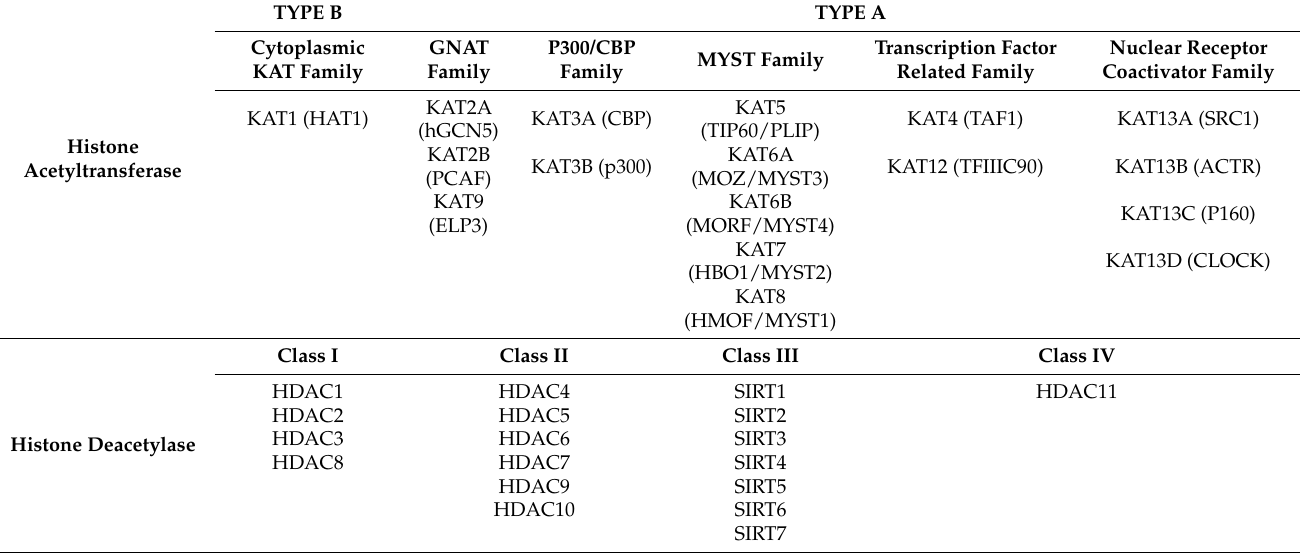
Table 1. Histone acetylation and deacetylation are performed by KATs and HDACs, respectively. Two types of KATs are defined: type A and B. Type A KATs have a nuclear localization and modify chromatin-associated histones, whereas type B KATs, mainly localized at the cytoplasmic level, modify newly synthesized histones not incorporated in the nucleosome. KATs are classified into six families and HDACs into